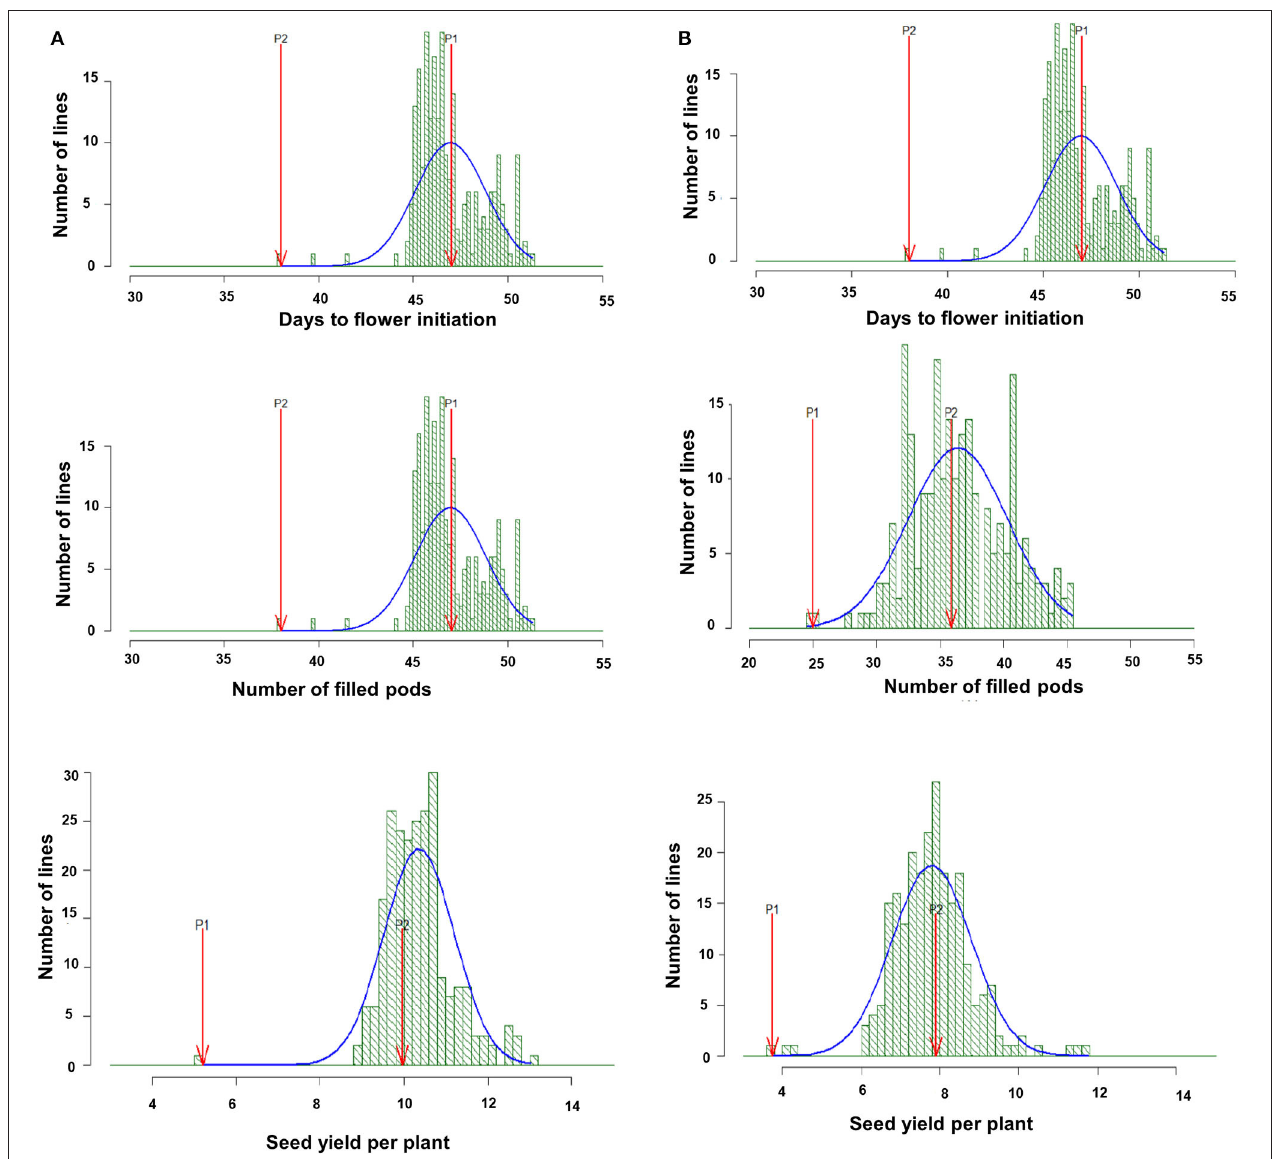
FIGURE 1 | Frequency distribution of days to flower initiation (DFI, d), total filled pods per plant (FP), and seed yield per plant (SYPP, g) in RIL population derived from DCP 92-3 × ICC 92944 and evaluated, under heat stress environment 2017–18 (A) and under heat stress environment 2018–19 (B)